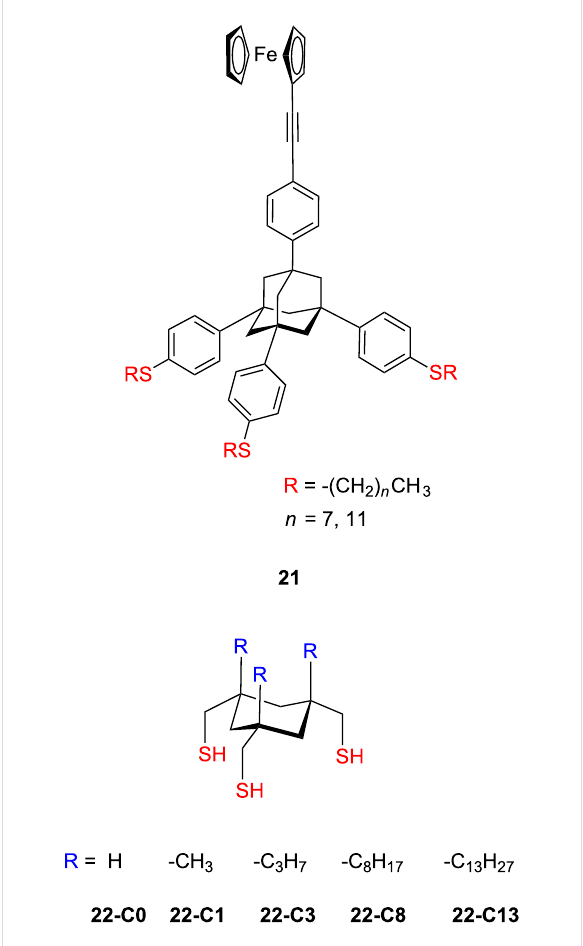
Figure 10: Adamantane and cyclohexane-based tridental